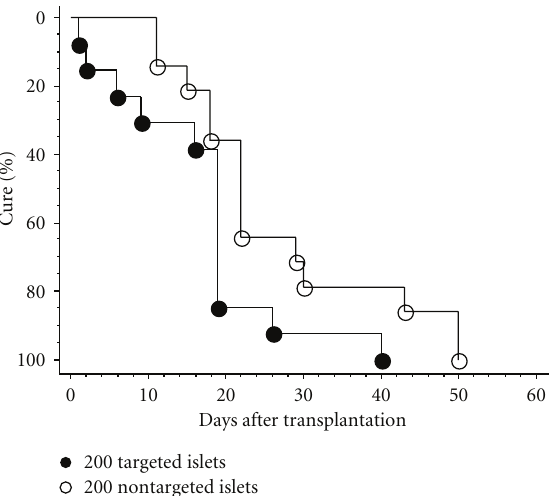
Figure 4: Curves of cumulative diabetes mellitus cure rate for syngeneic islet transplantation. Each streptozotocin-induced diabetic mouse was transplanted with 200 mouse islets transduced with either shRNAs to p27 kip1 or the non-target shRNA control implanted underneath the left renal capsule at day 0. Cure of diabetes was defined as the stable restoration of normoglycemia ( < 200 mg/dL glucose). Percent cure 50 (%) stands for half number of the transplanted diabetic mice becoming normoglycemia. The beneficial e ff ect of p27 kip1 silencing on the function of islet grafts was reflected by the high cumulative cure rate of diabetes. The di ff erence between two groups was analyzed with the log rank test. The value of the comparison for targeting versus non-targeting was P < 0 .